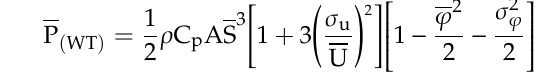
Figure 3. Fixed-speed wind turbine induction generator.